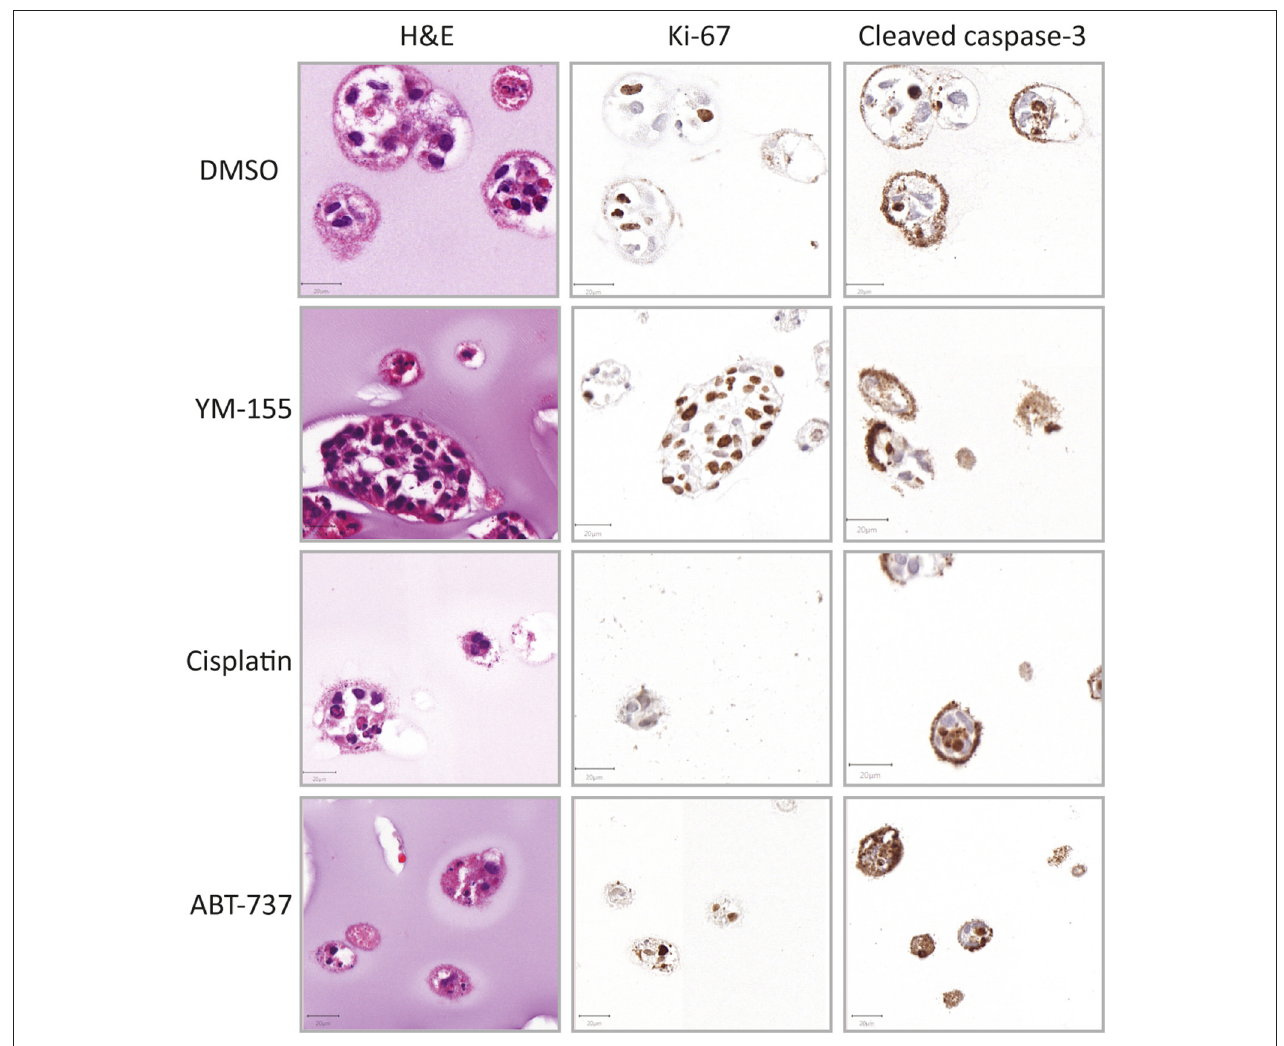
FIGURE 4 | Histological evaluation after treatment (CH2879). Morphology (HandE), level of proliferation (Ki-67) and apoptosis (cleaved caspase-3) were evaluated after treatment (YM-155 = 100nM, cisplatin = 10 µ M, ABT-737 = 31.6 µ M). YM-155 treatment indicated presence of smaller, treatment affected, as well as larger, unaffected, proliferative spheroids. Cisplatin treatment resulted in presence of smaller spheroids as well as global cell death and ABT-737 treatment induced apoptosis ( n = 1). Scale bar = 20 µ